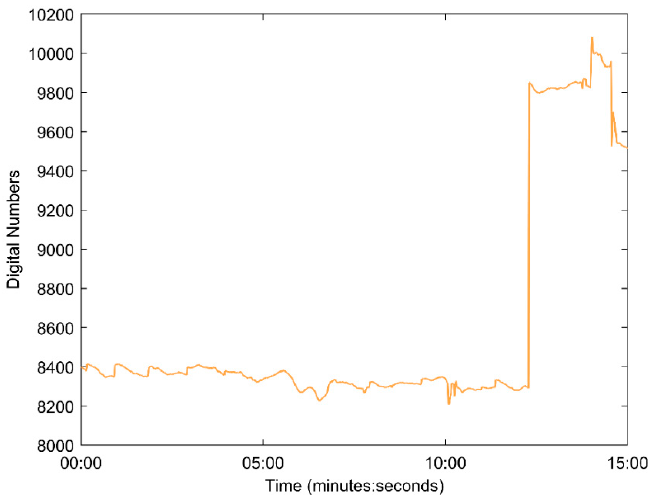
Figure A2. Time series of mean camera digital number from images recorded every second during the camera stabilization time before Flight A.